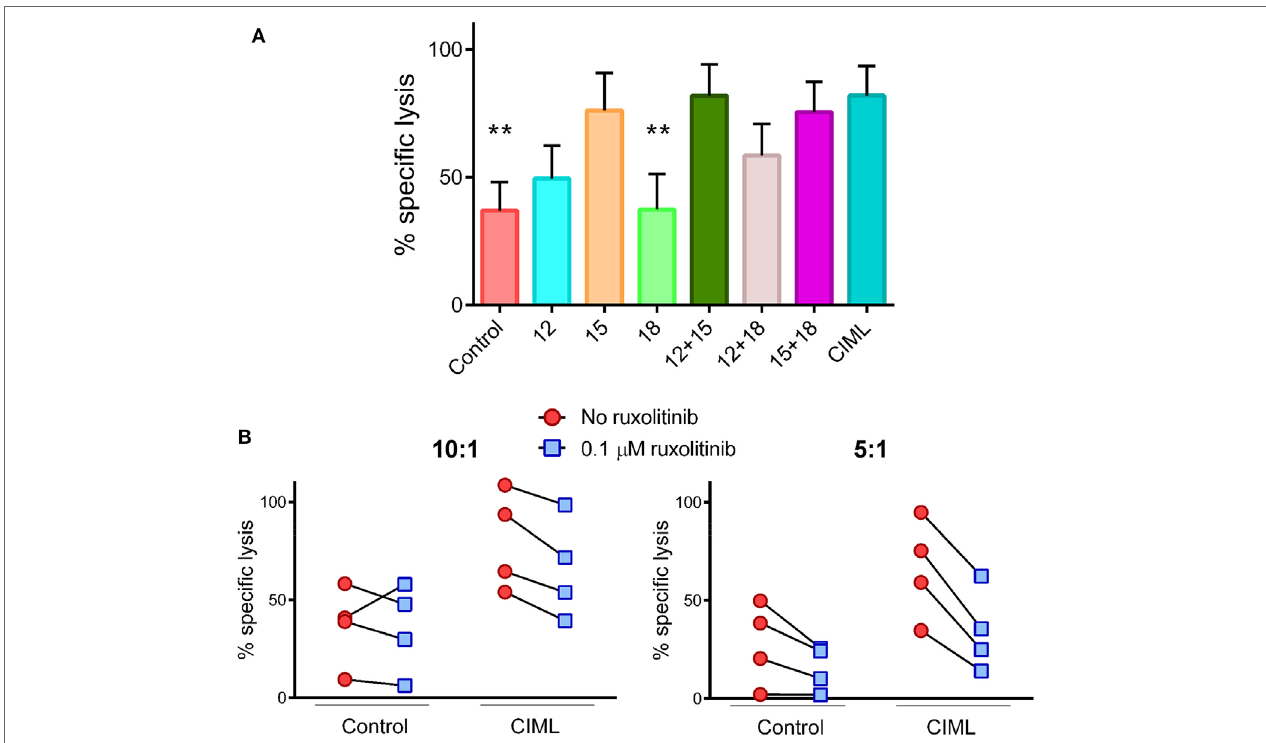
FigUre 2 | Cytotoxicity of cytokine preactivated natural killer (NK) cells at the end of the preactivation phase. (a) Bar graph showing the specific lysis of K562 target cells by control non-preactivated and cytokine preactivated NK cells at 10:1 E:T ratio ( n = 4). The bar graph shows the mean with SEM. Differences between cytokine-induced memory-like (CIML) NK cells and the rest of conditions were established with Friedman test. (B) Dot plot graphs showing the specific lysis of K562 target cells by control non-preactivated and CIML NK cells exposed or not to 0.1 µM ruxolitinib at 10:1 (left) and 5:1 (right) E:T ratios ( n = 4). ** p <